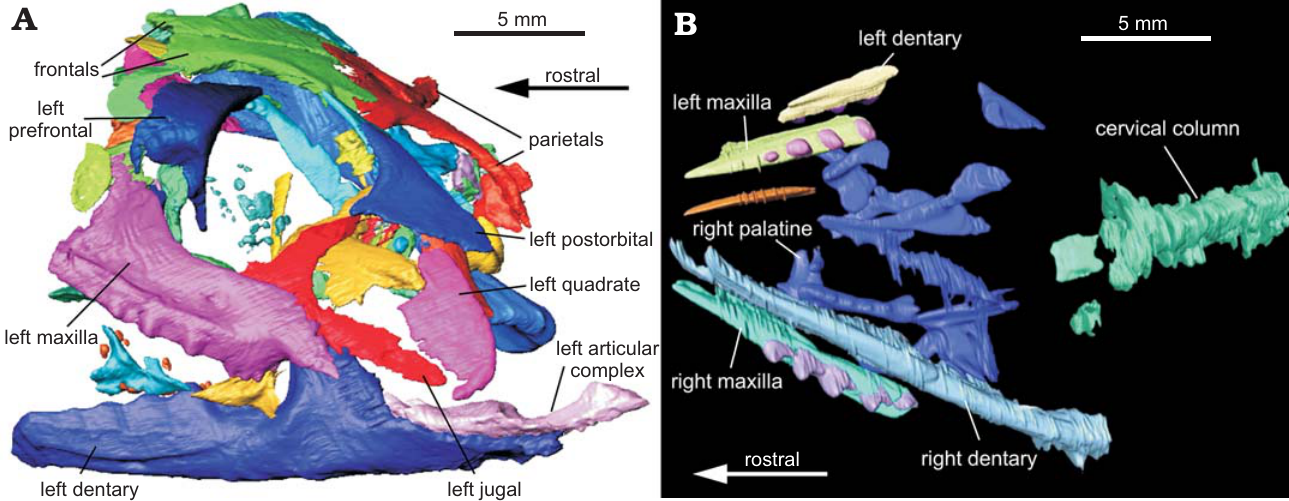
Fig. 1. The two surface data-sets of lepidosaur rynchocephalians. A . Clevosaurus hudsoni Swinton, 1939 (NHMUK PV R36832) from Rhaetian, Cromhall Quarry, England, UK, the left side of the digitally segmented skull in lateral view, adapted from O’Brien et al. (2018). B . Clevosaurus cambrica Keeble, Whiteside, and Benton, 2018 (NHMUK PV R37014) from Late Triassic, Pant-y-ffynnon, Wales, UK, available prior to this paper, the digitally segmented skull in ventral view, adapted from Keeble et al.